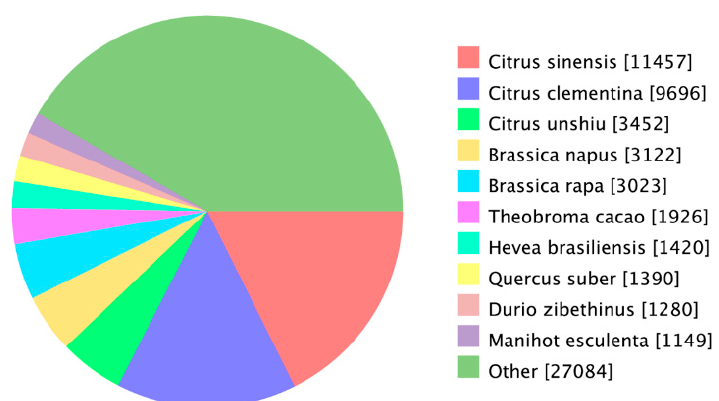
Figure 7. Homologous species distribution by Nr database. The best hits with an E -value = 1.0 × 10 − 5 for each query were grouped according to species.